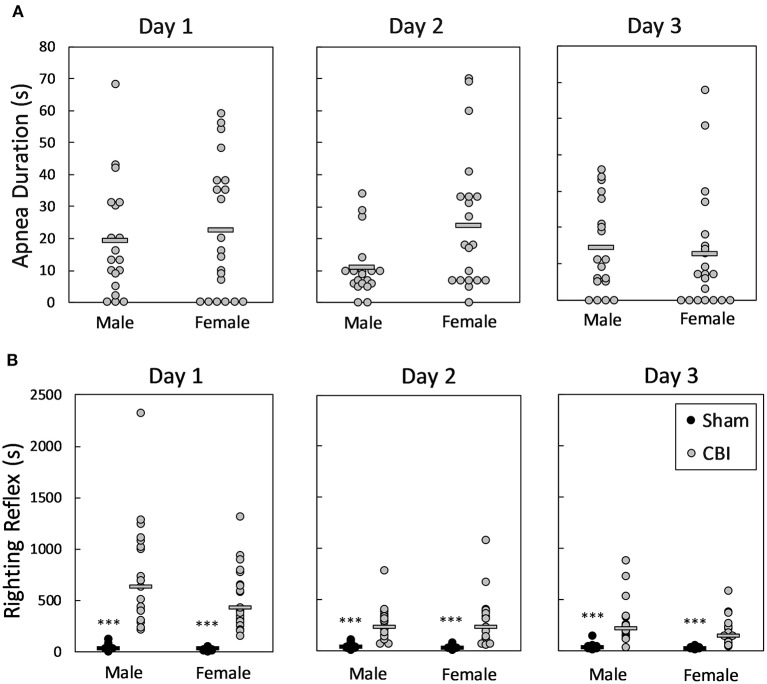
Apnea (A) and righting reflexes (B) following CBI on each injury day. Shown are individual data points; bars in (A) represent group means, in (B) represent group medians. The legend in lower right panel applies to all plots. There were no significant differences between male and female mice in the duration of apnea following CBI on any of the injury days (A). On each of the injury days, mice sustaining injury had significantly longer righting reflexes than sham-treated mice of the same sex (B). The asterisk (***) in (B) represents a significant effect of injury in the given sex, where CBI > Sham, p < 0.0001. There were no significant differences in righting reflex times between male and female mice, either injured or sham-treated. CBI, concussive brain injury.